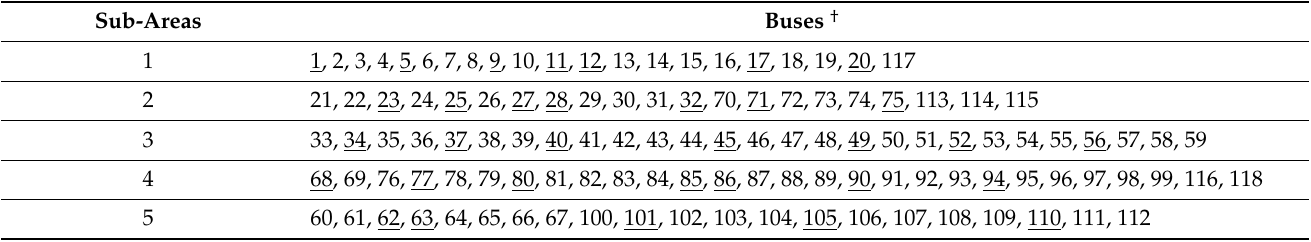
Table 13. Buses in the five sub-areas in the IEEE 118-bus network.